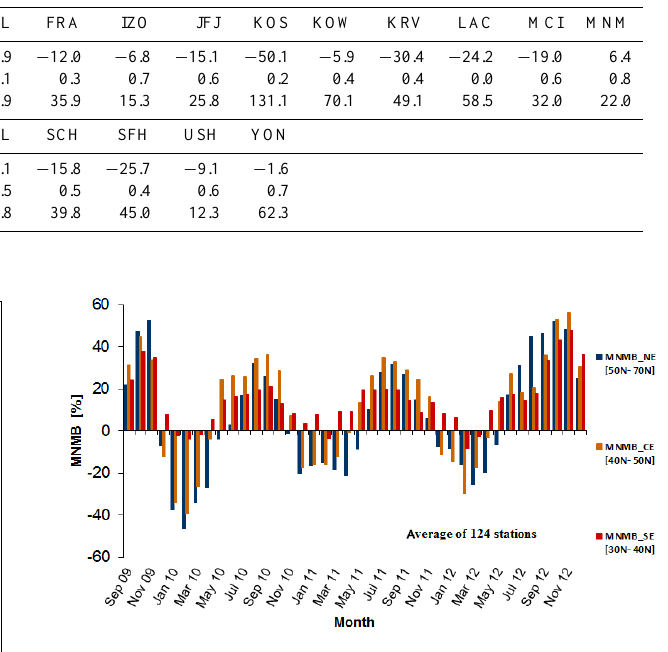
Figure 7. Modified normalised mean biases (MNMBs in %) de- rived from the evaluation of the MACC_osuite with EMEP O 3 sur- face observations in three different parts in Europe (blue: northern Europe, orange: central Europe, red: southern Europe) during the period September 2009 to December 2012.